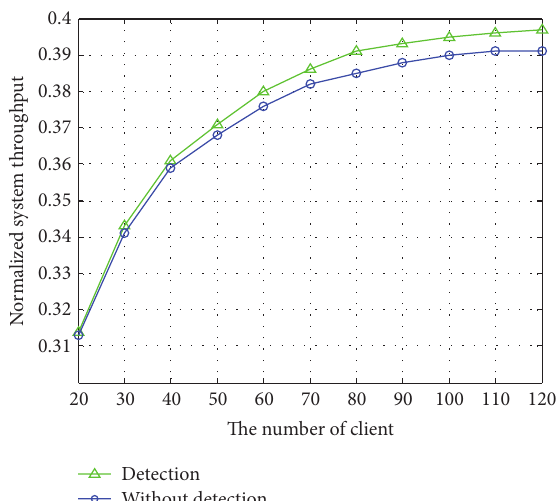
Figure5: ComparisonofDPDCIalgorithmunderdetecting already deployed APs and not detecting already deployed